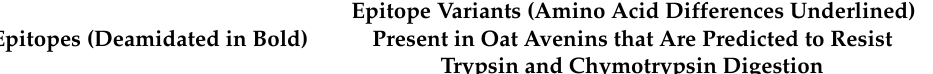
Table 1. Variants of T cell epitopes present in oat avenins that are predicted to resist trypsin and chymotrypsin